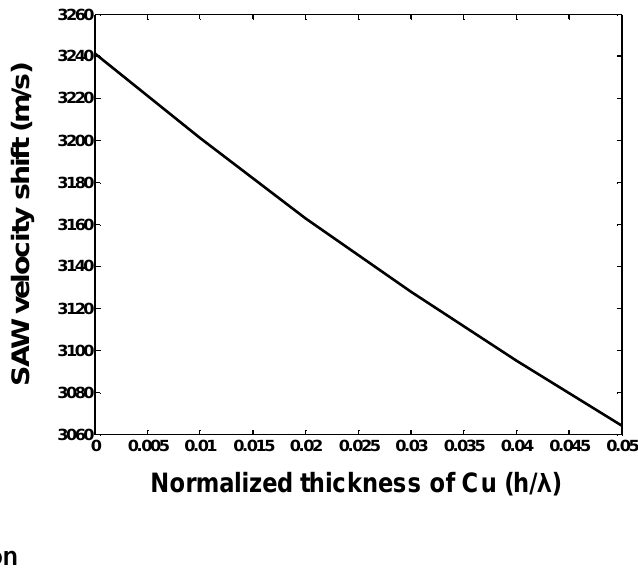
Figure 4. The SAW velocity shift depending on the normalized Cu thickness under given normalized rotation of